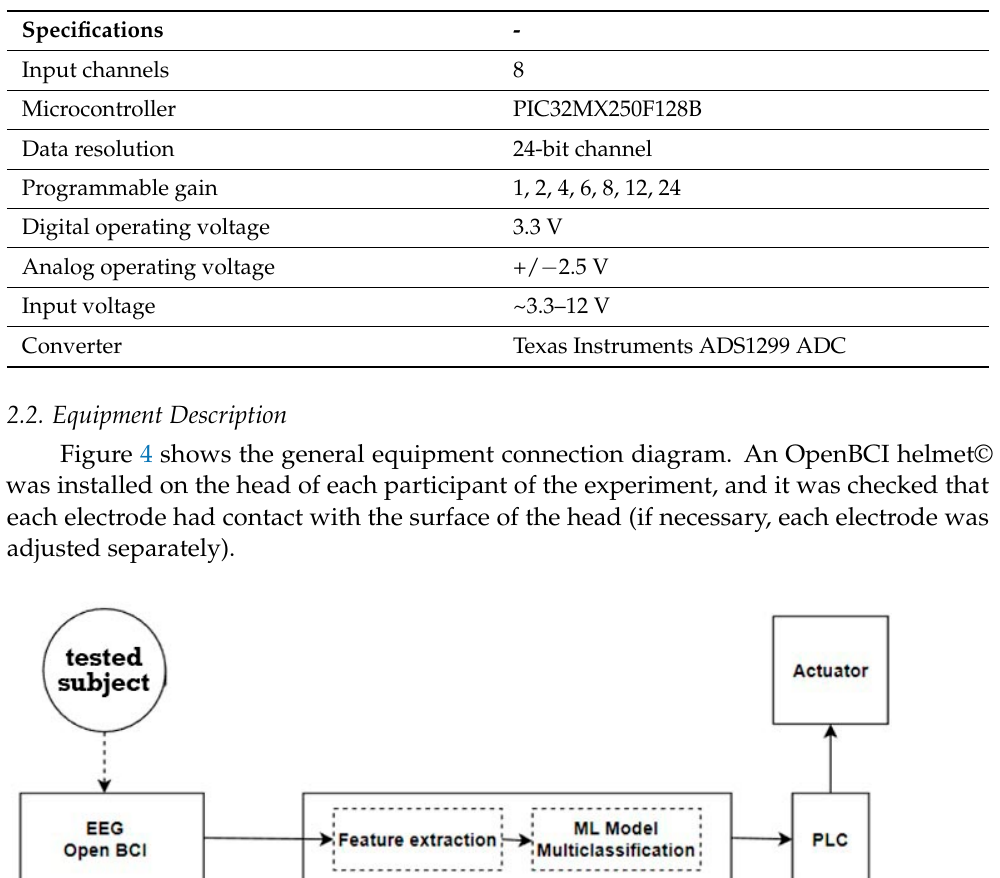
Table 2. Hardware specification of OpenBCI Dongle.